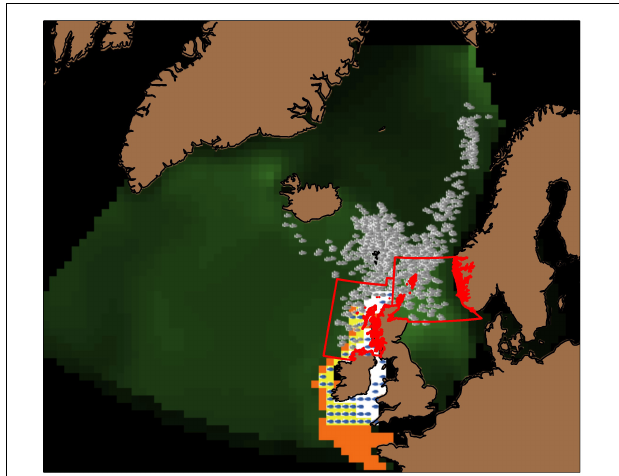
FIGURE 1 | Snapshot of the IBM interface on August 1st 2009. Gray SIs in the Nordic and North Seas are adults, and blue SIs to the west of the British Isles are juveniles. The color of the landscape indicates phytoplankton density: darkest green equals 0 g m − 2 through light green which equals 3 g m − 2 . Orange cells indicate potential spawning areas, white cells potential nursery areas, and yellow cells indicate areas that are both potential spawning and nursery areas. The nursery area is delimited by the 200 m isobath to the west of the British Isles, and the potential spawning area corresponds to the European shelf edge ( − 500 m < depth < − 50 m). The red boxes (ICES divisions 6a and 4a) delimit the potential overwintering areas. The easternmost box (division 4a) is that which we close in our spatial management scenarios (see Table 2